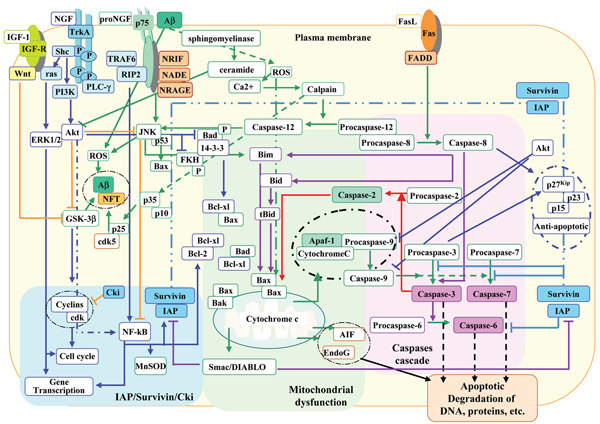
A molecular model of neuronal apoptosis organized in submodules. The central part of the model (green panel) represents the mitochondria submodule and all the molecules that regulate its function as "sensor" of the cellular stress responses (yellow panel). Dark blue and green arrows indicate survival and apoptotic pathways, respectively; orange arrows indicate inhibitions. Red arrows indicate the positive feed-back, while in purple and light blue are indicated the cross-talk between extrinsic/intrinsic apoptotic cascades and the survival regulatory control by IAPs, respectively. More information is the text.